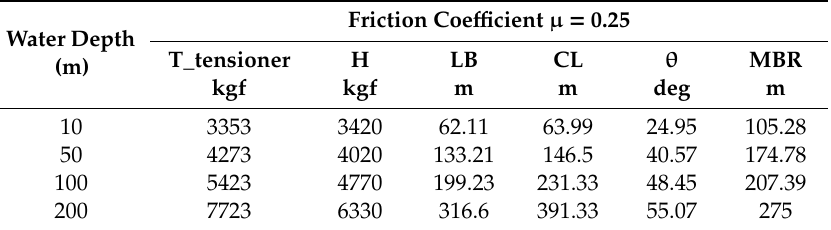
Table 9. Cable critical responses assuming friction coe ffi cient µ =